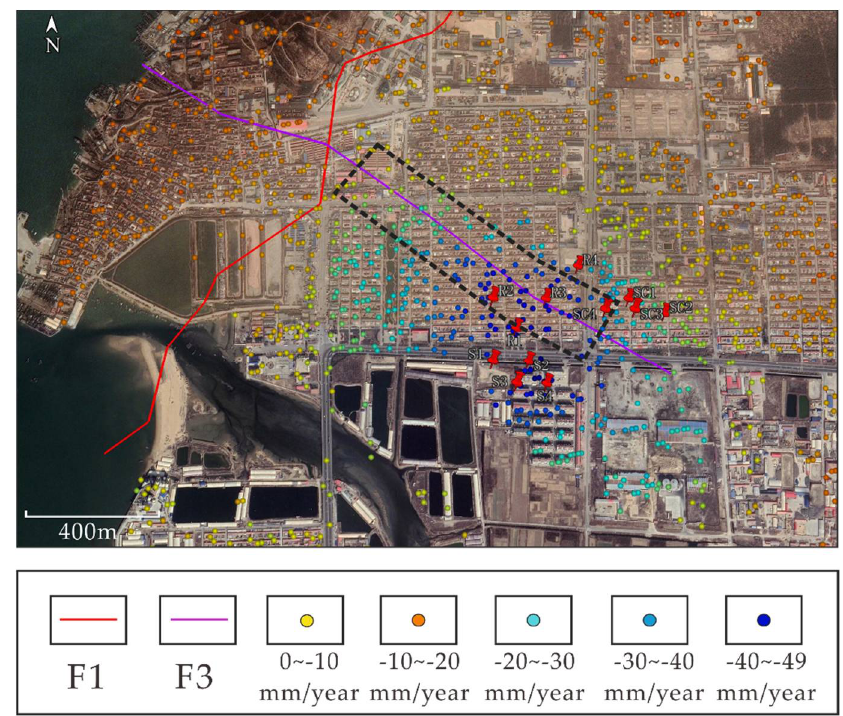
Figure 11. The LOS velocity map overlaid on Google Earth, the selected analysis range (black dashed box) and the location of representative sites are shown on the map.